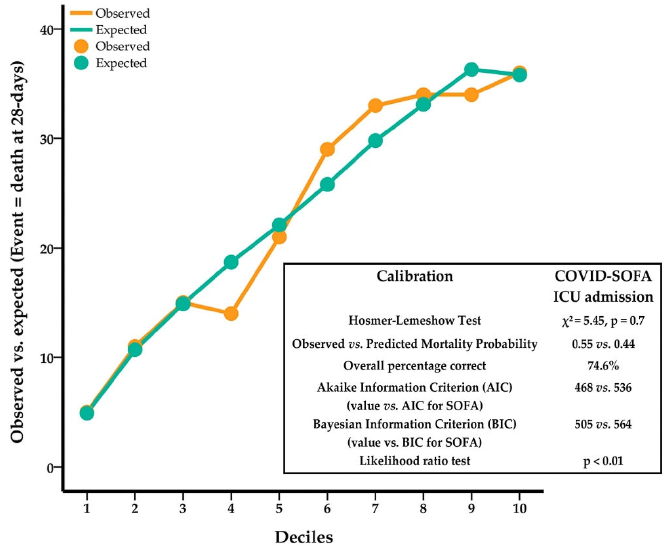
Figure 2. Calibration plot and COVID ‐ SOFA score’s goodness ‐ of ‐ fit.